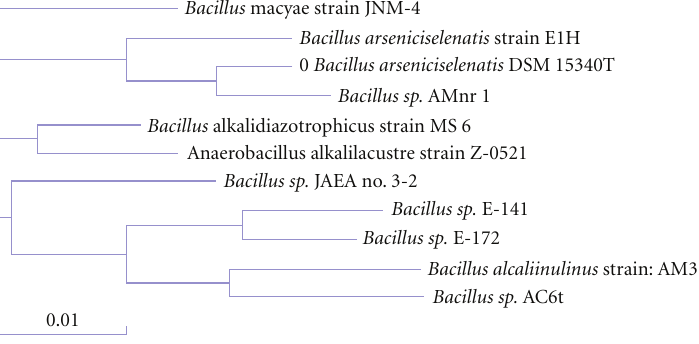
Figure 2: The phylogenetic tree of Bacillus arseniciselenatis DSM 15340 (designated as “0”).